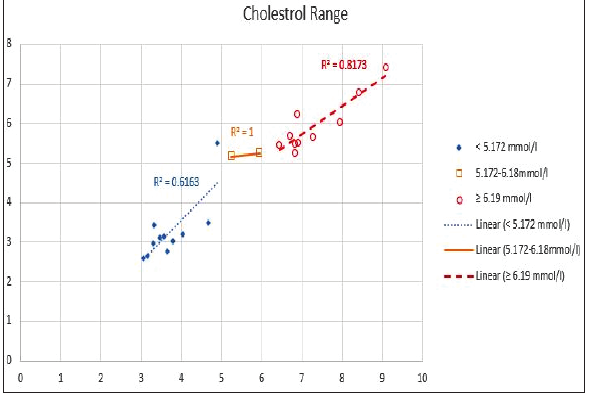
Fig-6: Correlation between Device method and lab method according to Cholesterol level after optical window cleaning (overall R 2